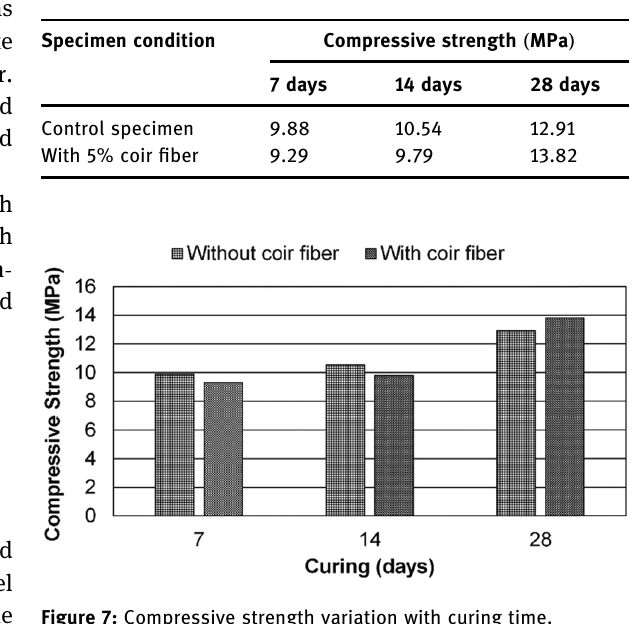
Table 6: Compression test on cylindrical specimens